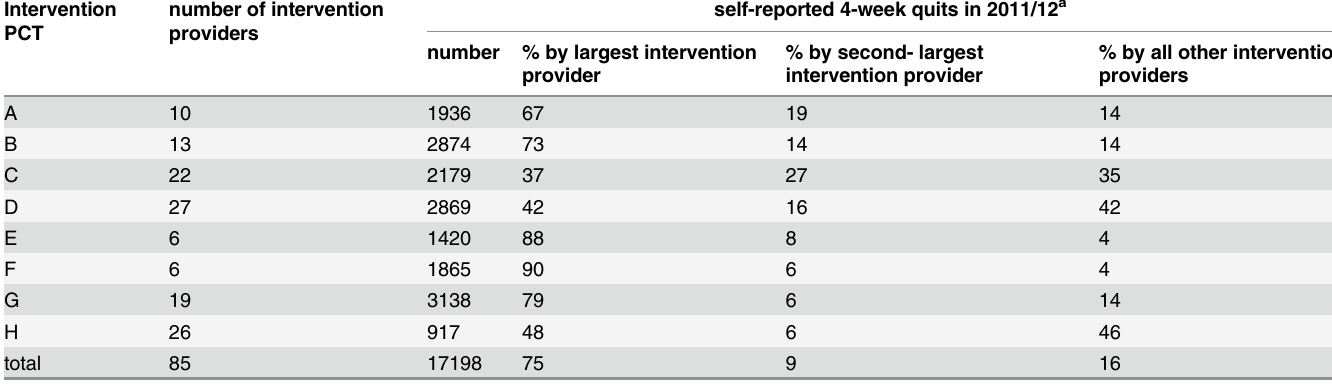
Table 3. Number of providers and percentage of quits by intervention PCTs Intervention